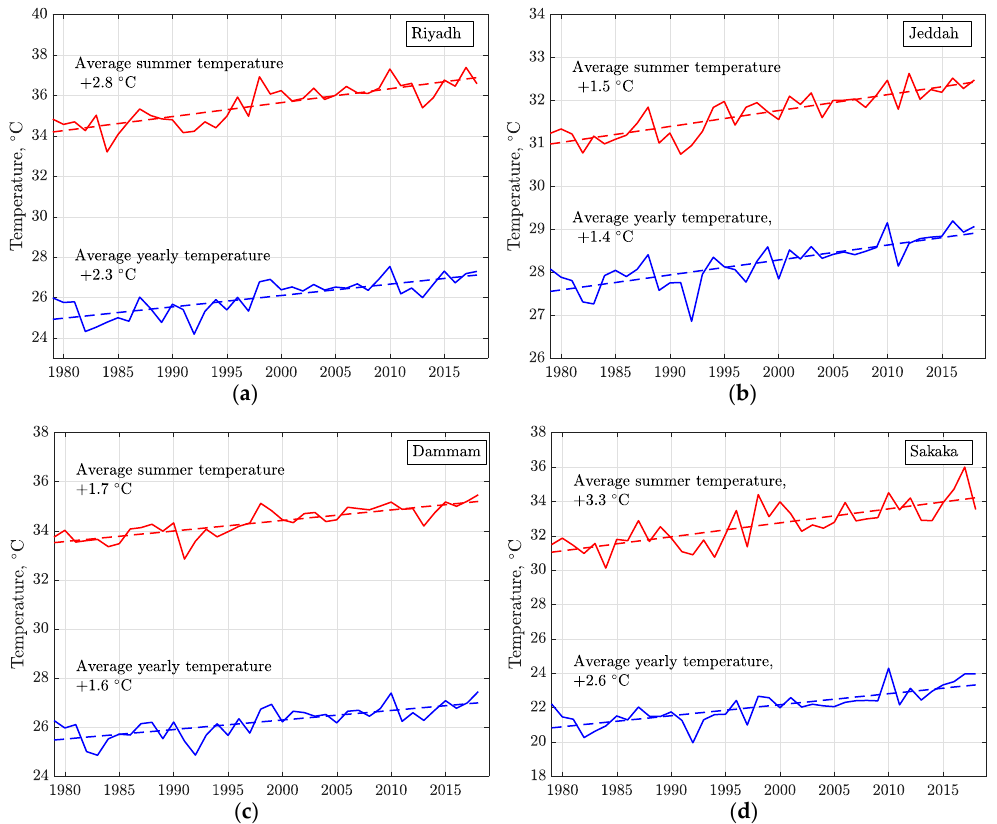
Figure 9. Linear warming trend for ( a ) Riyadh [24.75 ° N 39.25 ° E] ( b ) Jeddah [21.50 ° N 39.25 ° E] ( c ) Dammam [26.50 ° N 50.00 ° E] and ( d ) Sakaka [30.00 ° N 40.25 ° E] over the past 40 years based on average yearly temperature. Source: Authors based on ECMWF ERA5 Dataset.